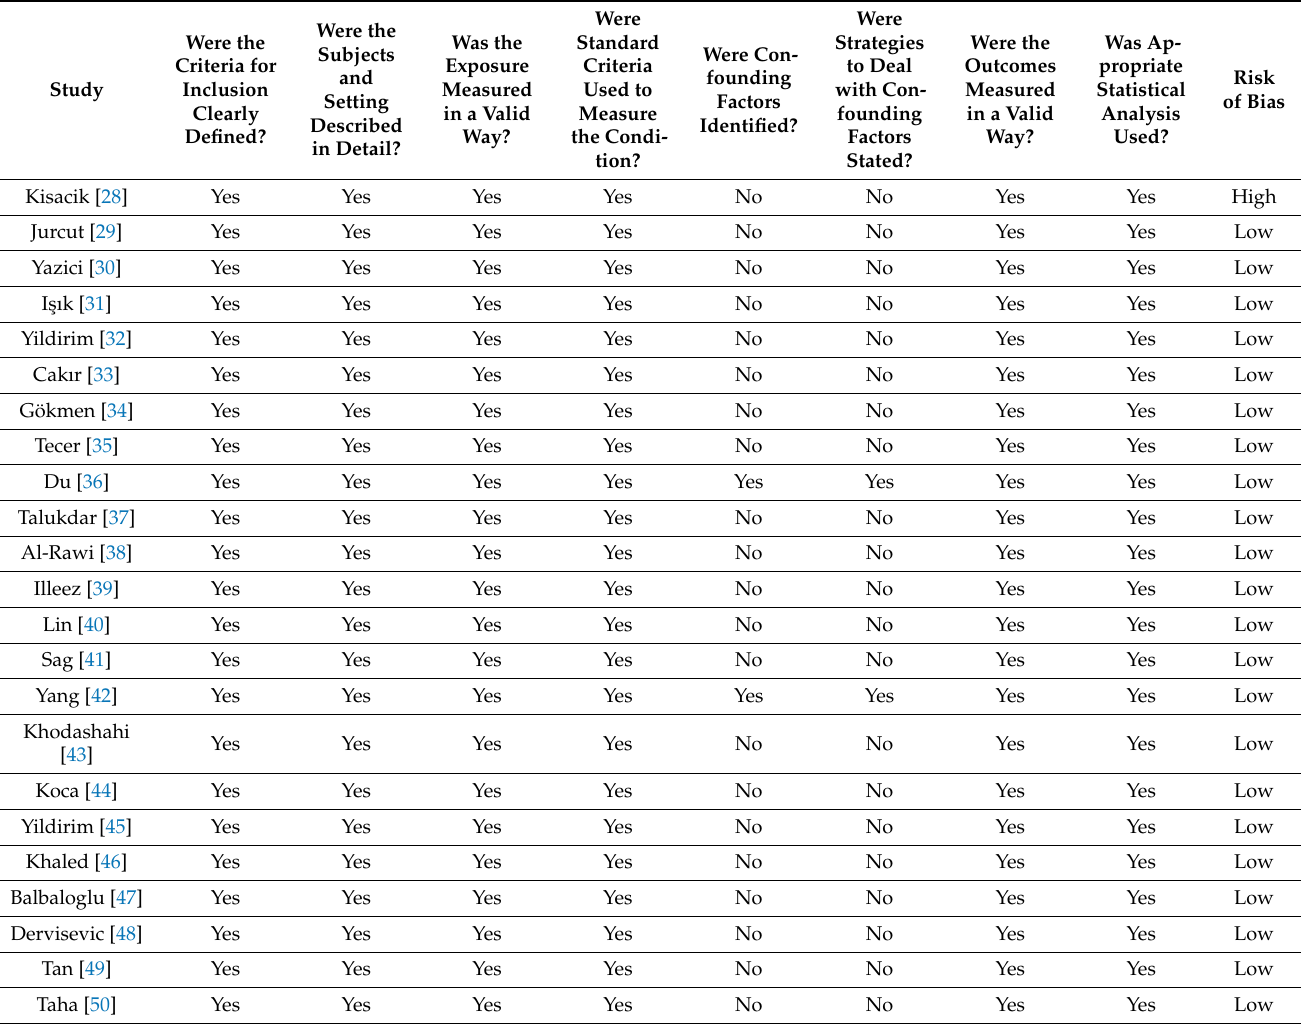
Table 2. The Joanna Briggs Institute critical appraisal